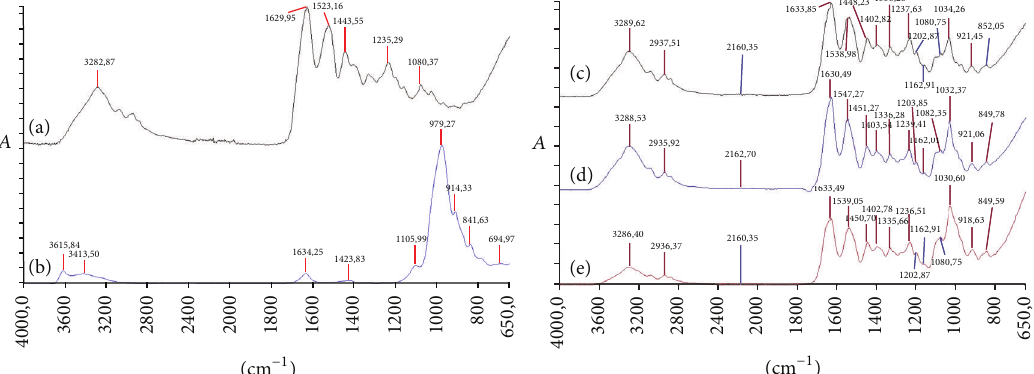
Figure 4: FTIR spectra of (a) gelatin and (b) MMT powder and 5% of gelatin-based nanocomposites prepared with (c) 0%, (d) 5%, and (e) 10% of MMT.